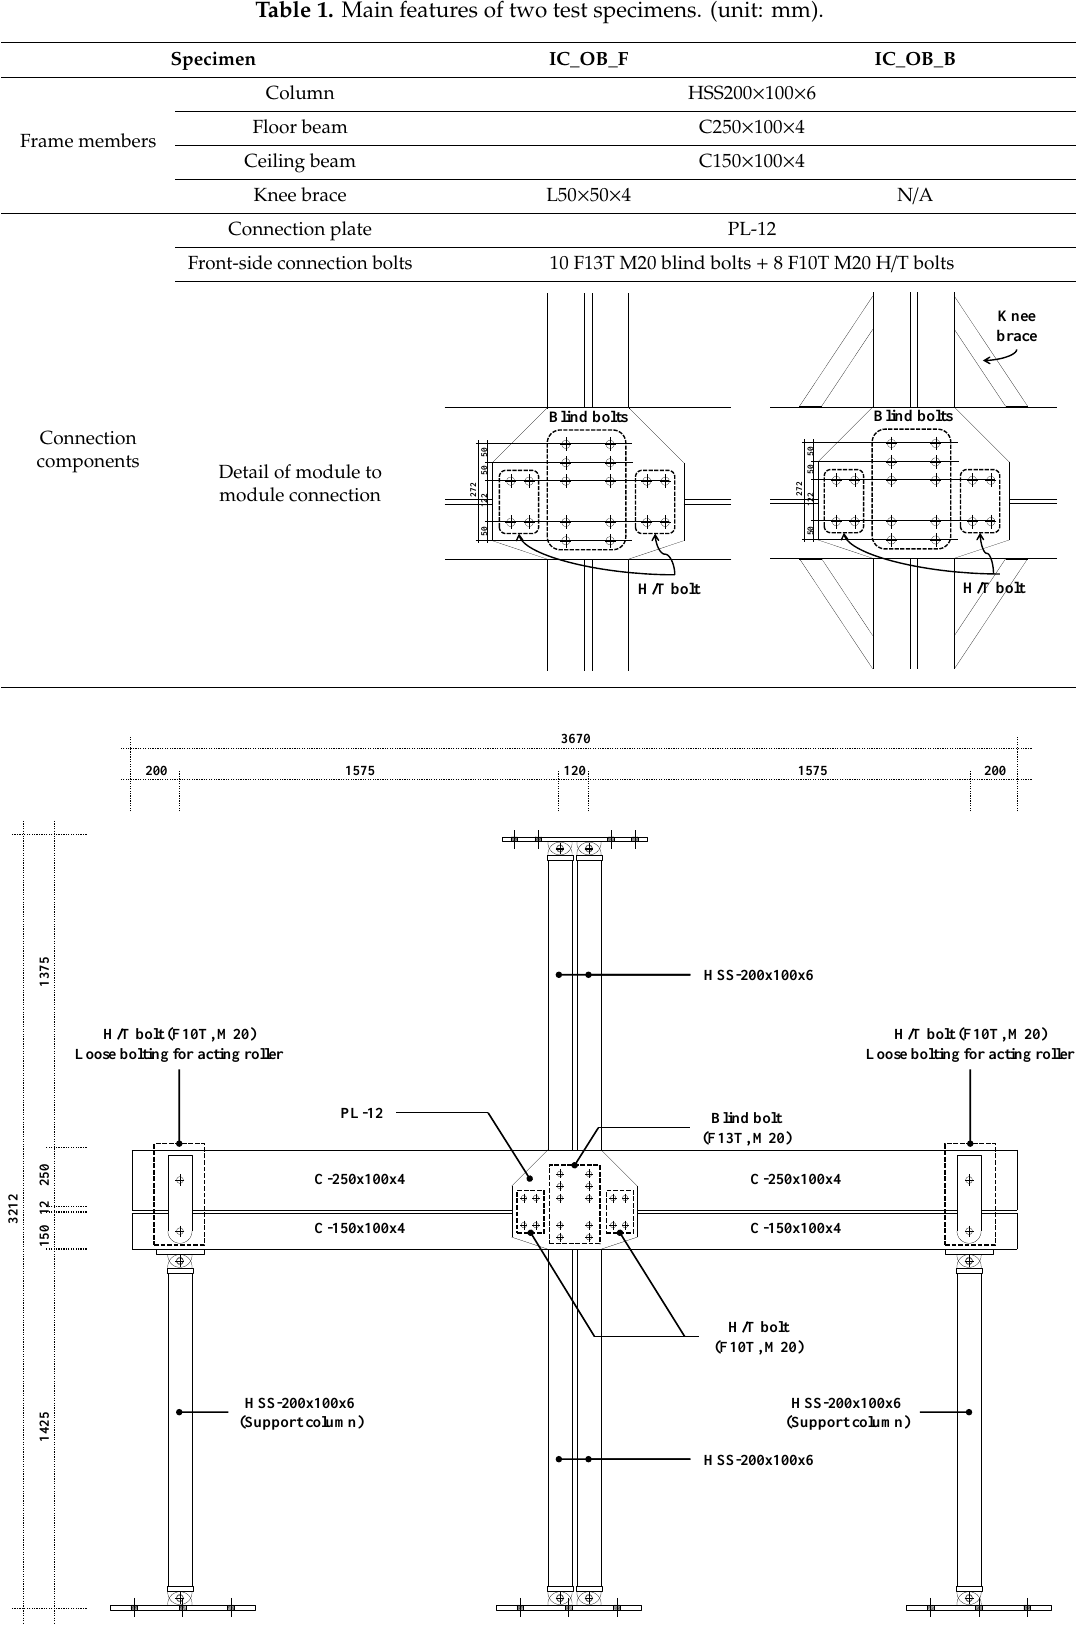
Figure 6. Details of specimen IC_OB_F.